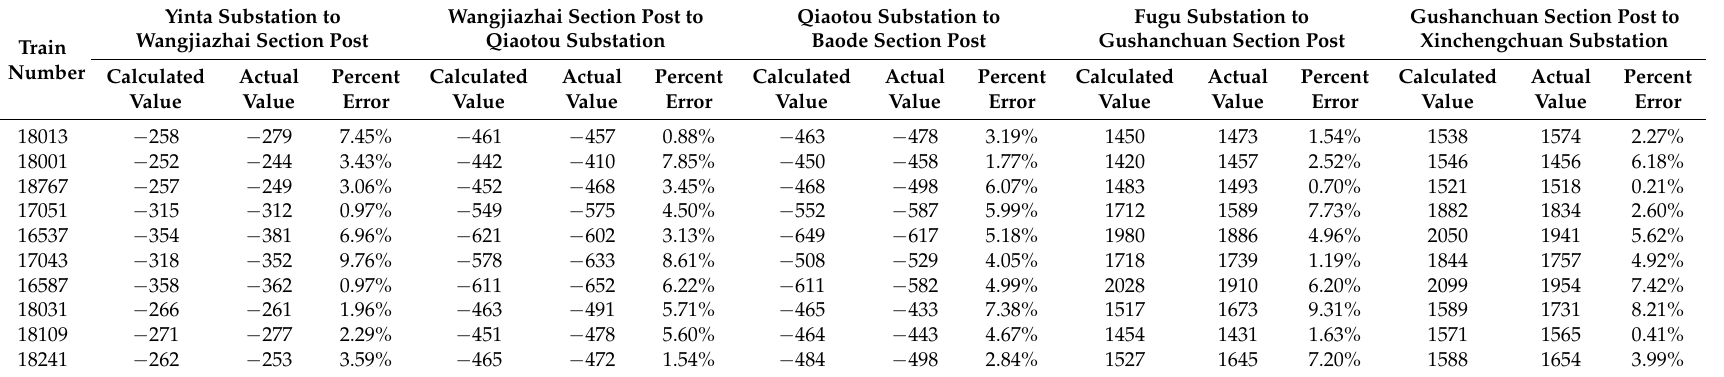
Table 5. Verification results of interval energy consumption and regenerative braking energy for downstream AC